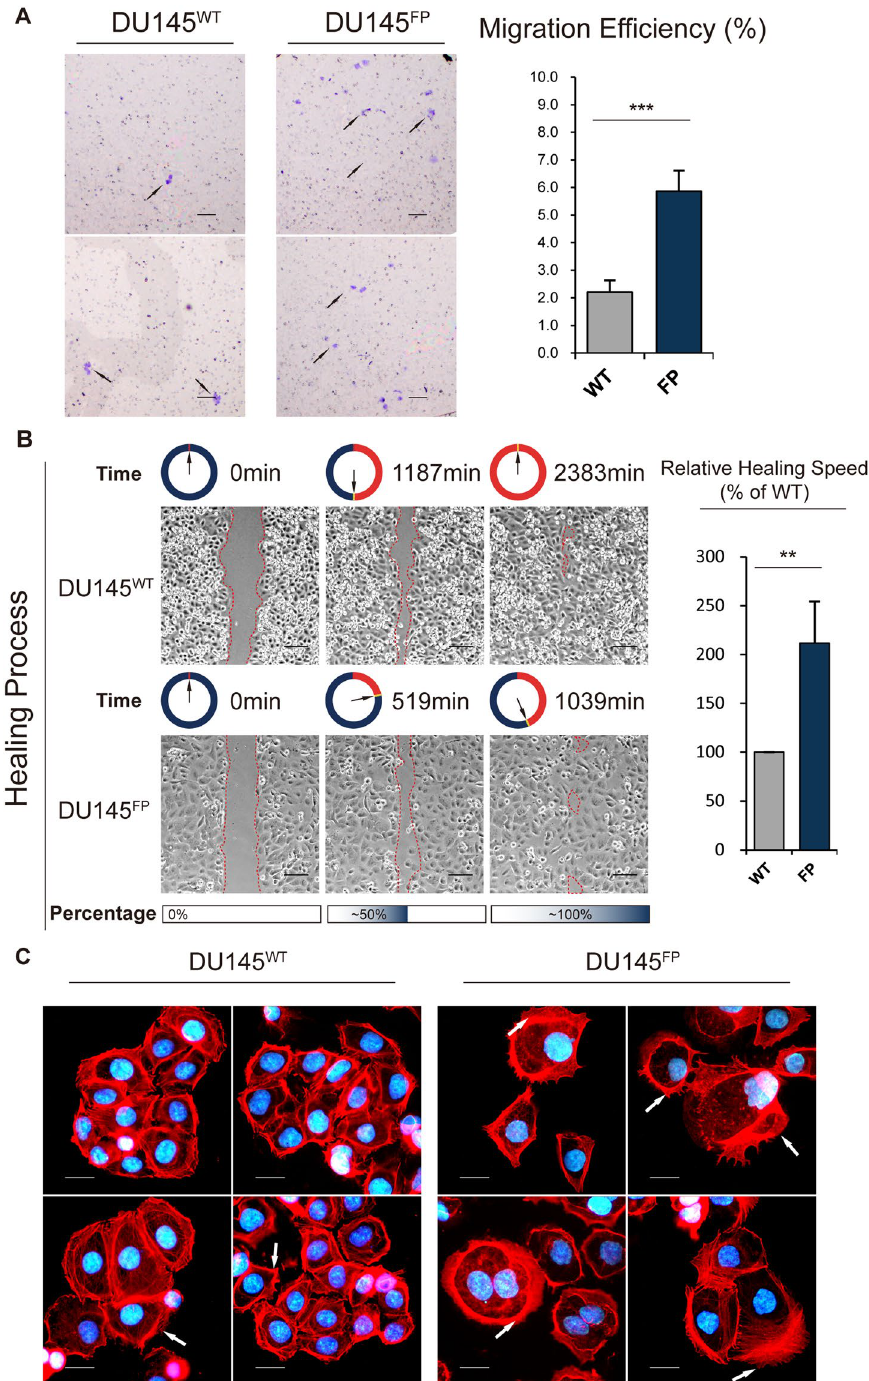
Figure 4. DU145 FP cells display a higher mobility and well-developed lamellipodia. ( A ) Cell motility assessed by transwell assays. The data is presented as means from three independent experiments, each experiment includes at least two parallel samples (mean ± S.D). The bars are equal to 200 µ m. ( B ) The wound-healing assay obtained by live cell imaging system. The red dashed lines indicate the scratch area. The wound widths and corresponding relapsed time were measured using software Adobe Photoshop and Microsoft Excel, and the cells’ healing speeds were calculated. The data is presented as means from three independent experiments (mean ± S.D). The bars are equal to 100 µ m. ( C ) The cells were stained with the rhodamine conjugated phalloidin for the purpose of visualizing F-actin and lamellipodia. The cell nuclei were co-stained with DAPI showing in blue. The bars are equal to 20 µ m. Statistical significance: * p < 0.05, ** p < 0.01, *** p <